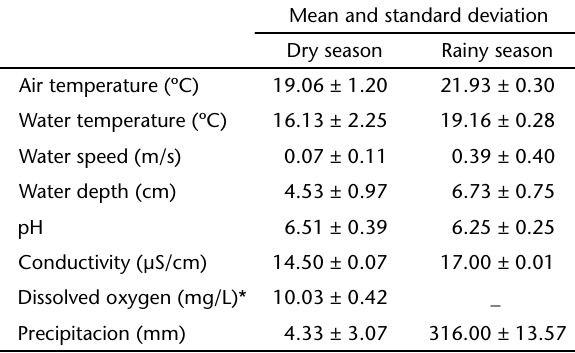
Table I. Characterization of the studied stream, located in the Poço D’Anta Municipal Biological Reserve, during the dry and the rainy season.